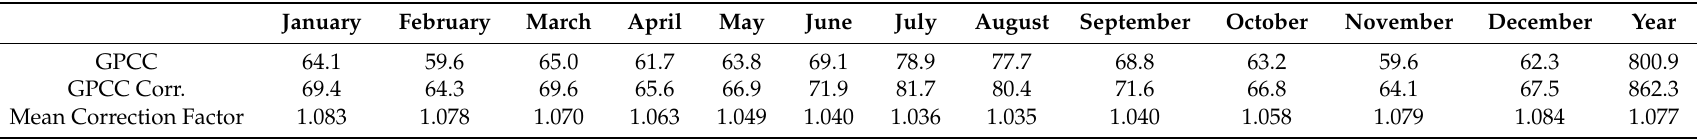
Table 1. Mean (GPCC) and mean corrected (GPCC Corr.) precipitation totals over the period 1982–2015 for the calendar months and the year, as well as mean correction factors for the systematic gauge-measuring error utilizing the weather